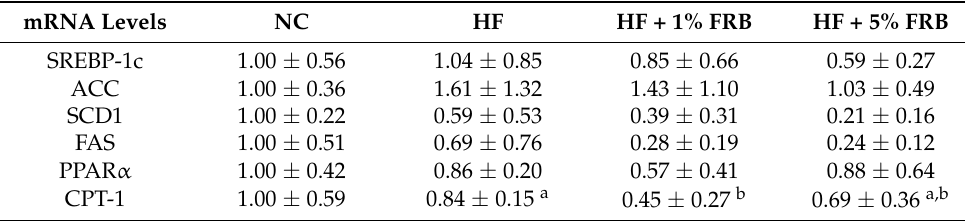
Table 6. Effects of the water extract of fermented rice bran (FRB) on hepatic fatty acid metabolism- related gene mRNA levels in aged rats with high-fat (HF) diet feeding. mRNA Levels